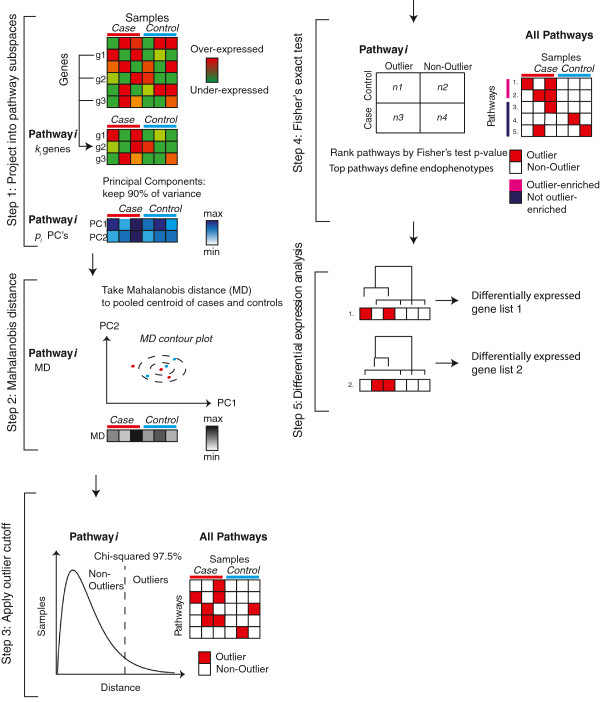
Analysis flow chart. In brief, the steps of the method were: 1) project samples onto the principal components (PC) of pathway subspaces, 2) calculate the 1-dimensional Mahalanobis distance distribution of samples in the PC space of each pathway, 3) classify samples as “outliers” or “non-outliers” in each pathway based on the 97.5th percentile of the chi-squared distribution, 4) employ Fisher’s exact test to identify pathways that are specifically enriched for case or control outliers, using the False Discovery Rate (FDR) q-value of Storey and Tibshirani to correct for multiple hypothesis testing [88], 5) for each subgroup of samples corresponding to the outliers in a candidate pathway, perform standard differential expression analysis to determine the genes responsible for the grouping.